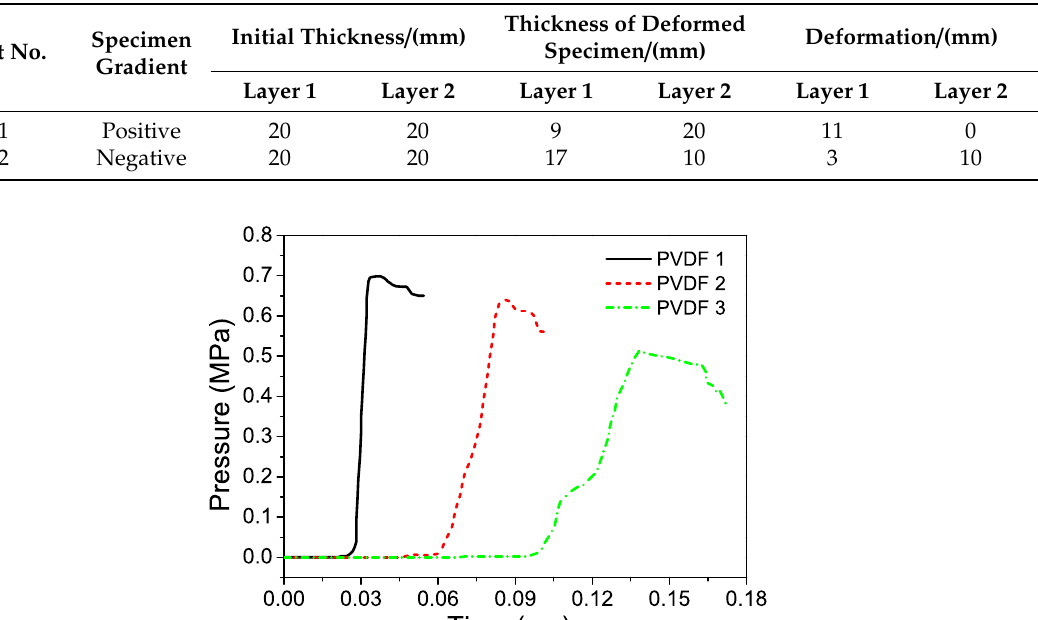
Figure 5. Pressure–time histories in positive aluminum foam specimen (test 1). PVDF 1 was sandwiched between an upper steel plate and layer 1; PVDF 2 was sandwiched between layer 1 and layer 2; PVDF 3 was sandwiched between layer 2 and the distal steel plate. Table 3. Deformation dimensions of deformed specimens.